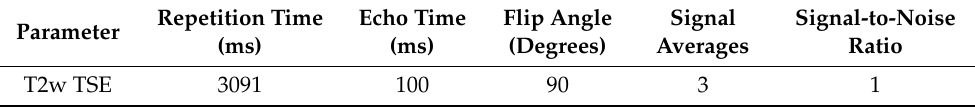
Table 1. Parameter of MRI